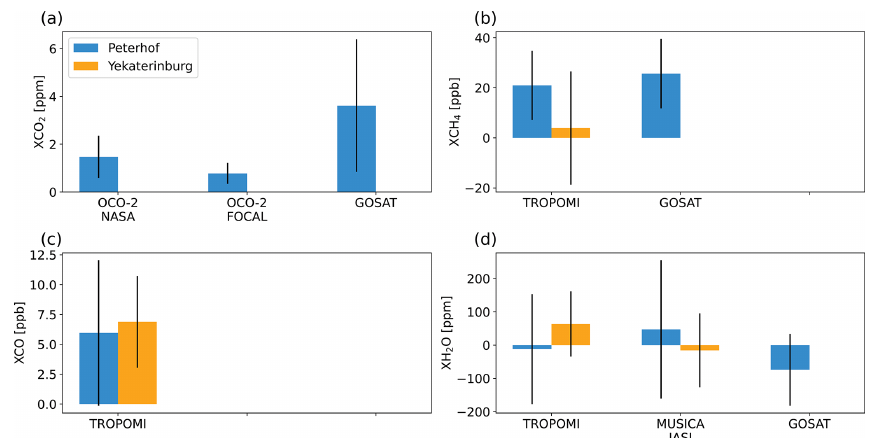
Figure 14. Bar plots of the averaged bias derived from different products with respect to COCCON for (a) XCO 2 , (b) XCH 4 , (c) XCO and (d) XH 2 O at Peterhof and Yekaterinburg. The error bars represent the standard deviation of the averaged